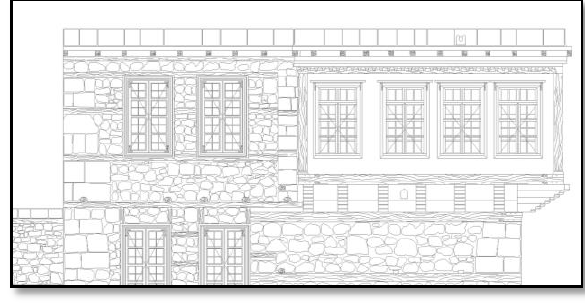
Figure 18. Restoration Project-Basement Floor Facade